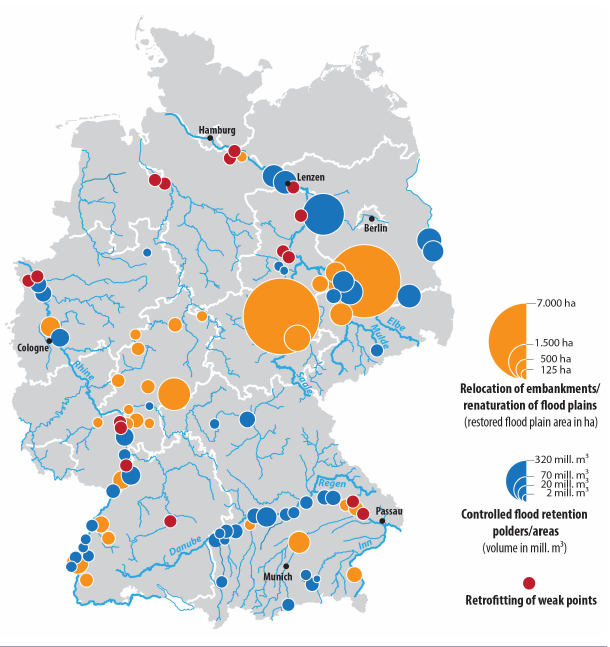
Fig. 2 . Projects of the National Flood Protection Program as of July